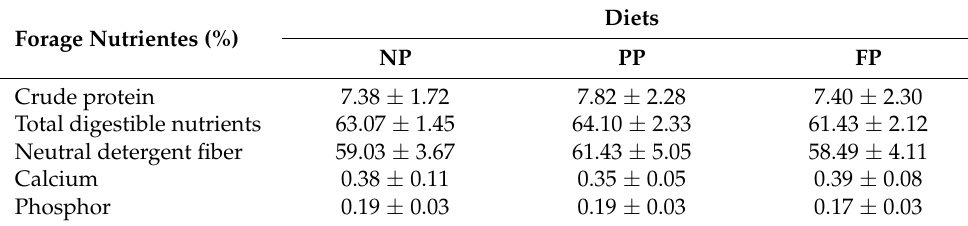
Table 4. Chemical composition of pastures consumed by cows in the different groups (mean ± standard